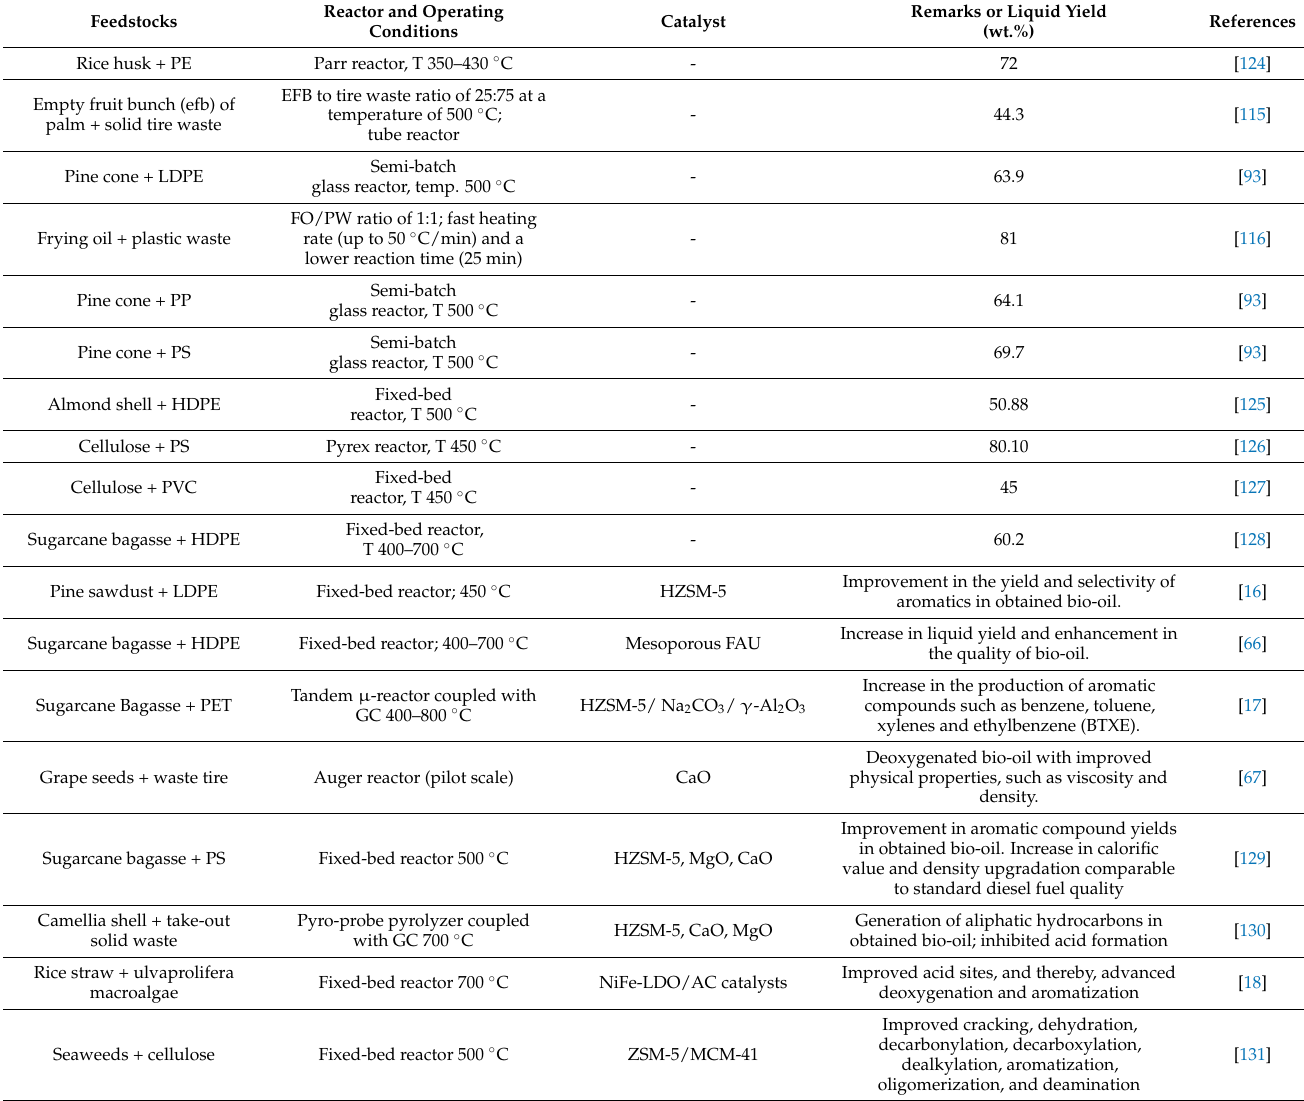
Table 3. Catalytic and non-catalytic co-pyrolysis and their various